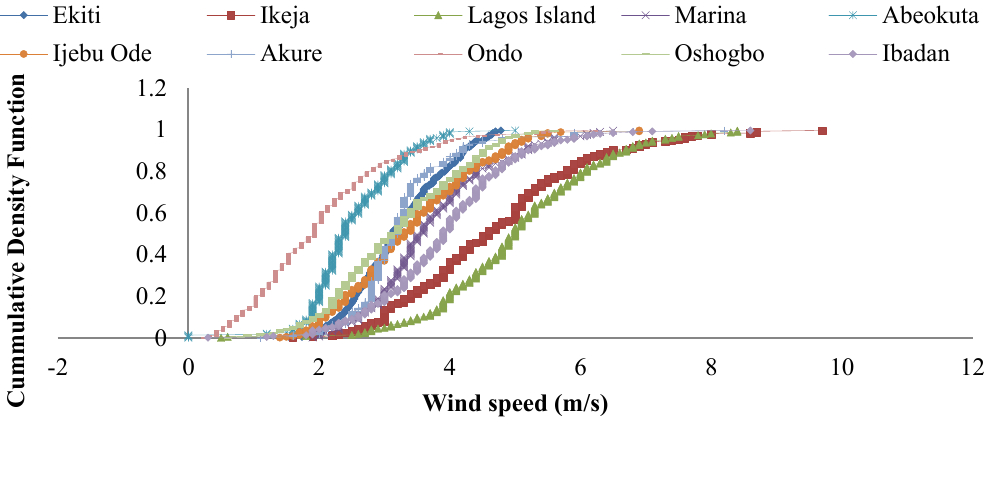
Figure 7. Whole year’s PDF Plots of all the stations.